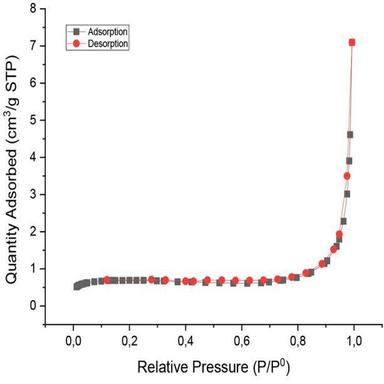
N2 adsorption–desorption curves of Perlite@GO.